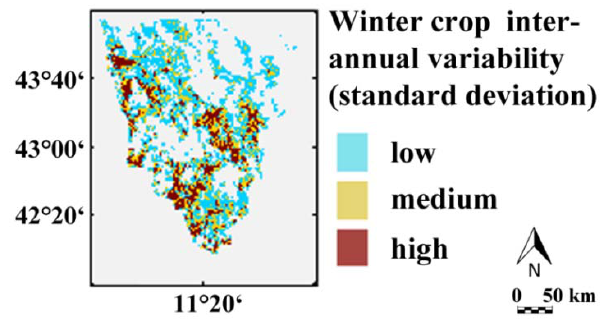
Figure 6. Inter-annual variability of winter crop acreages for AVHRR pixels with arable land. The map is derived from official AGRIT statistics and multi-annual (eight yrs) Landsat TM/ETM+ data. The inter-annual variability is expressed in standard deviations and grouped into three classes: low variability (STD < 5%), medium (5% < STD < 10%) and high variability (STD > 10%). Pixels without arable land (<2%) are shown in